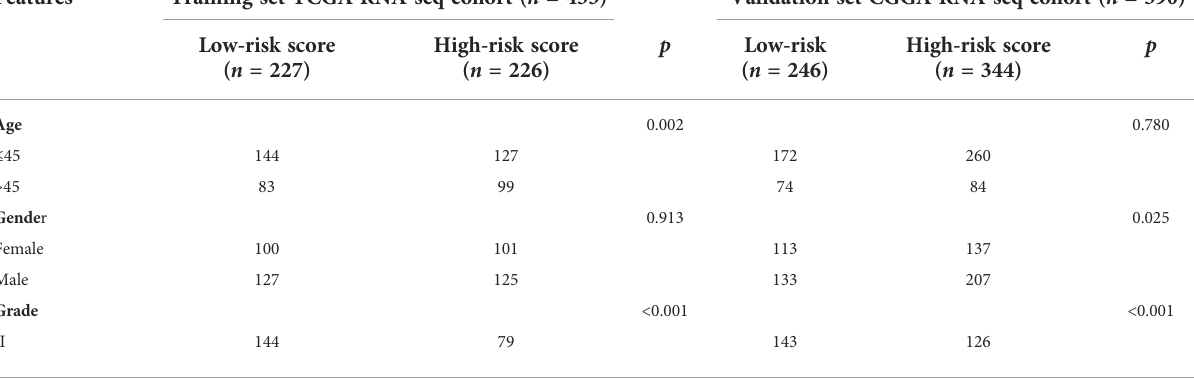
TABLE 1 Correlation between fi ve GSRS genes ’ risk scores and clinicopathological factors of glioma patients in the two cohorts.